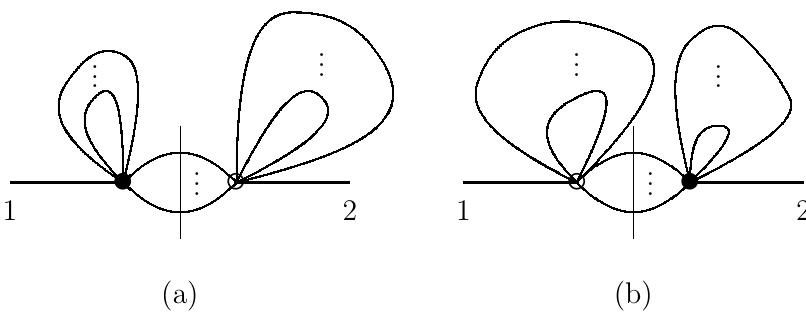
Figure 2 . Contributions to M ∗